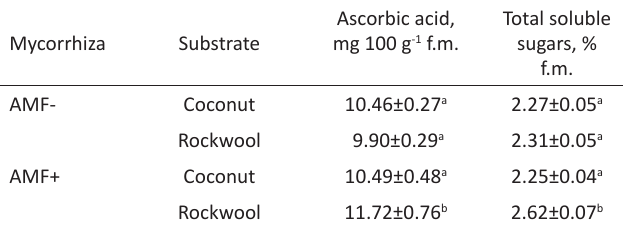
Table 4. Effect of interaction between mycorrhiza and type of substrate on ascorbic acid and total soluble sugars content in tomato fruits.